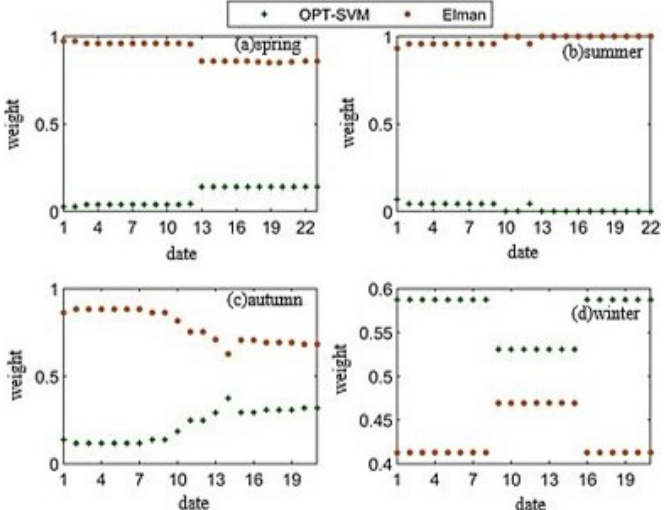
Figure 11. Time-varying weights of individual models through linear weighted average daily load